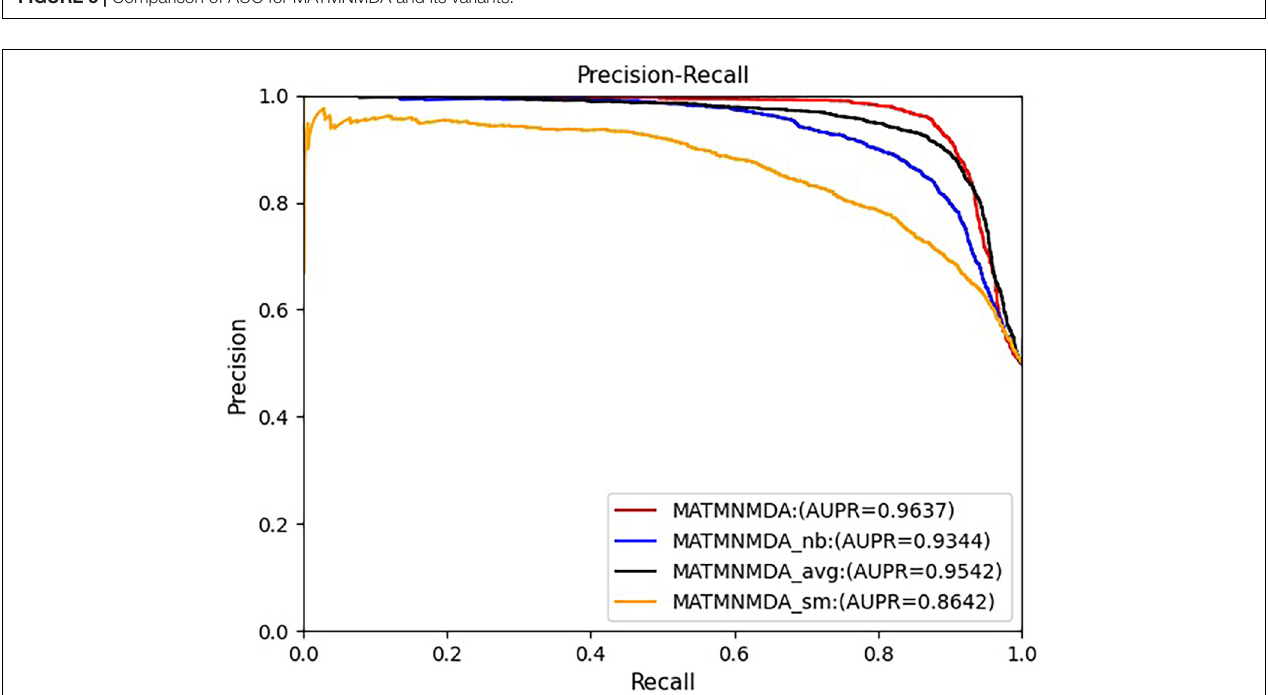
FIGURE 6 | Comparison of AUPR for MATMNMDA and its variants.